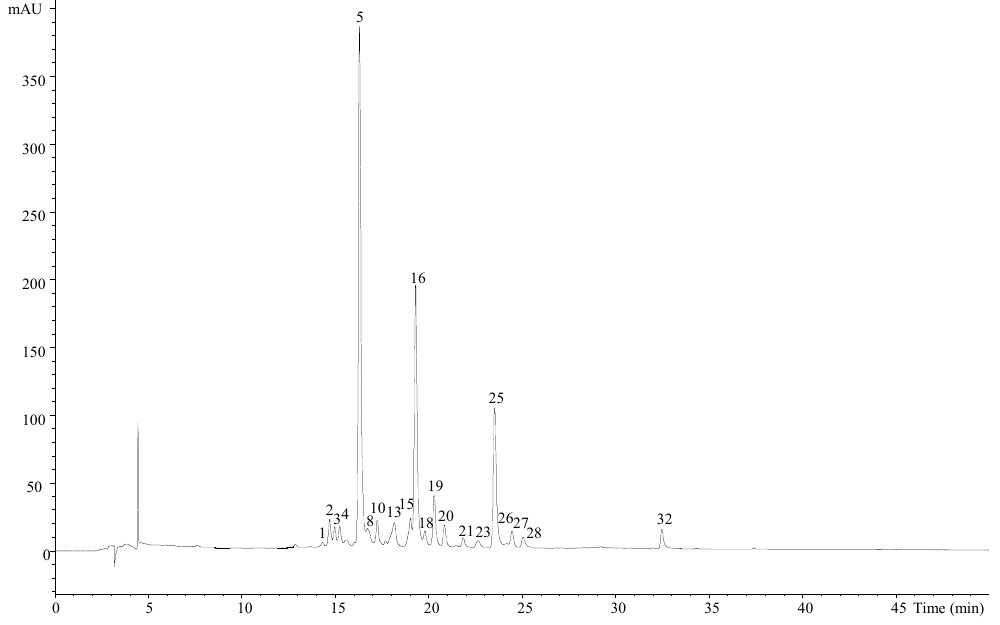
Figure 1. Individual phenolic compound profile of BB1 recorded at 370 nm. Peak numbering is the same as in Tables 1 and 2.